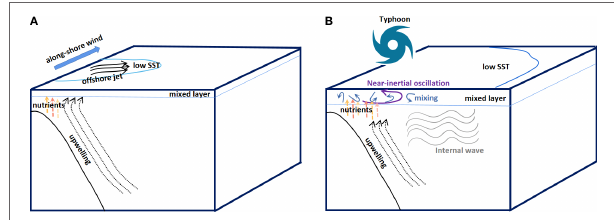
FIGURE 15 | Schematic diagram for typhoon influence on the coastal upwelling off eastern Hainan Island (HIU). (A, B) are used for typical summertime and typhoon period,